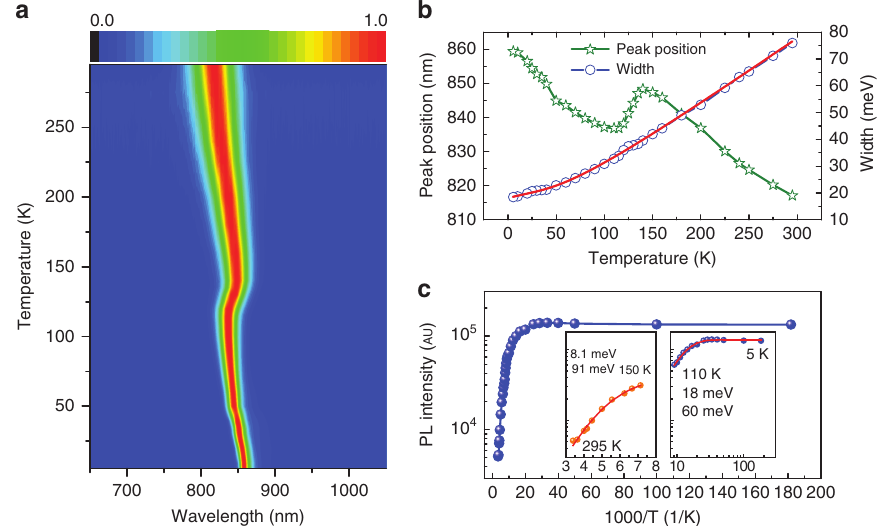
Figure 3 ( a ) 2D pseudo-color plot of the normalized emission spectra under a pump fl uence of 1.4 μ J cm − 2 at different temperatures; the PL spectra are normalized at their maximum intensity. ( b ) Peak position and FWHM of the PL spectra as a function of temperature. The red solid line is the result of a fi t, including contributions from inhomogeneous broadening, acoustic and optical phonons. ( c ) Temperature-dependent data of the integrated PL intensity. Inset: the fi tted curve from 295 to 150 K and from 110 to 5 extract emission spectra at different times after excitation. It is evident that the shape of the spectrum is independent of the time elapsed after excitation, as shown in Figure 2d. Similar behavior is displayed by the (FAI/PbI 2 +HI)- and FAI/PbI 2 -based fi lms.